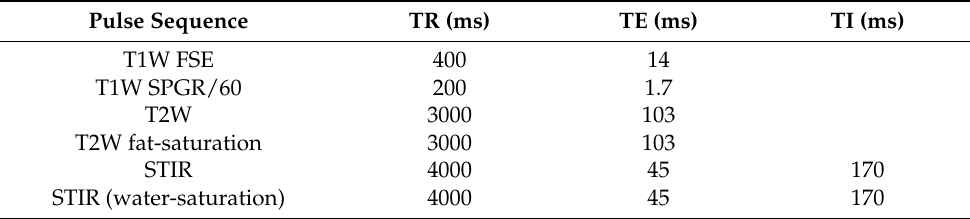
Table 1. Pulse sequences and parameters used in magnetic resonance